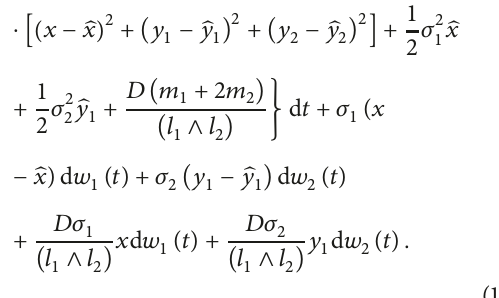
= 1 , and 𝜎 2 = 1 . 1 2